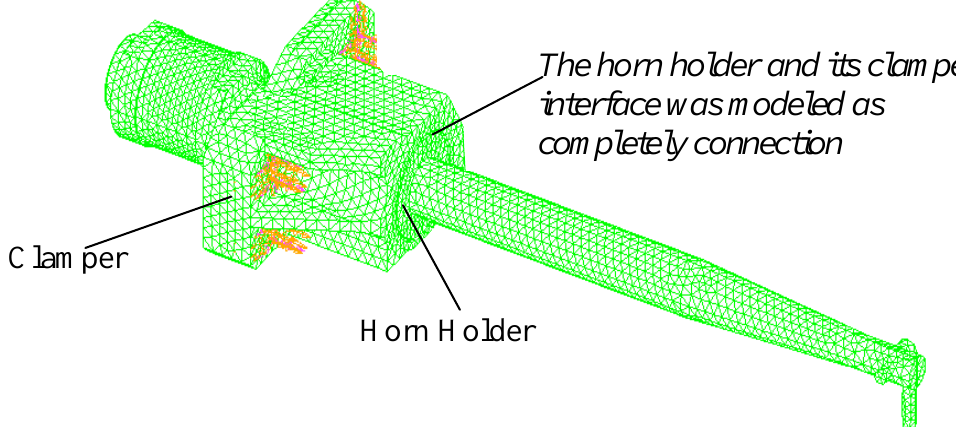
Figure 6. The transducer model with holder constrained through clamper fixed with four screws.